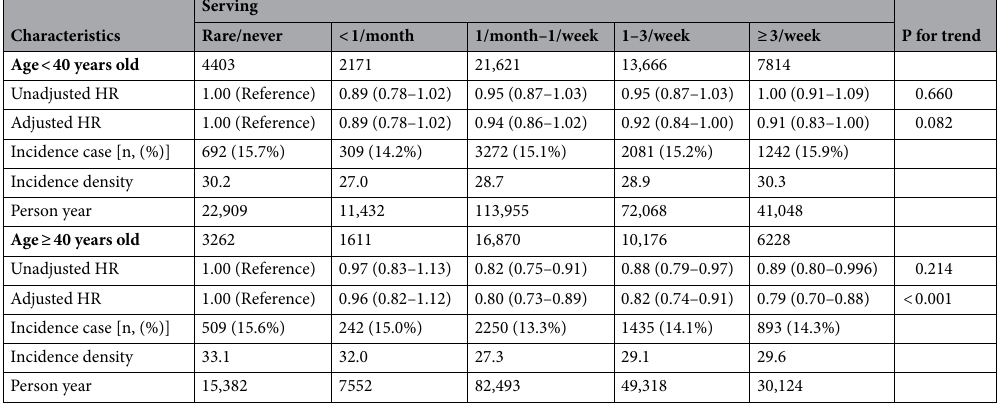
Characteristics